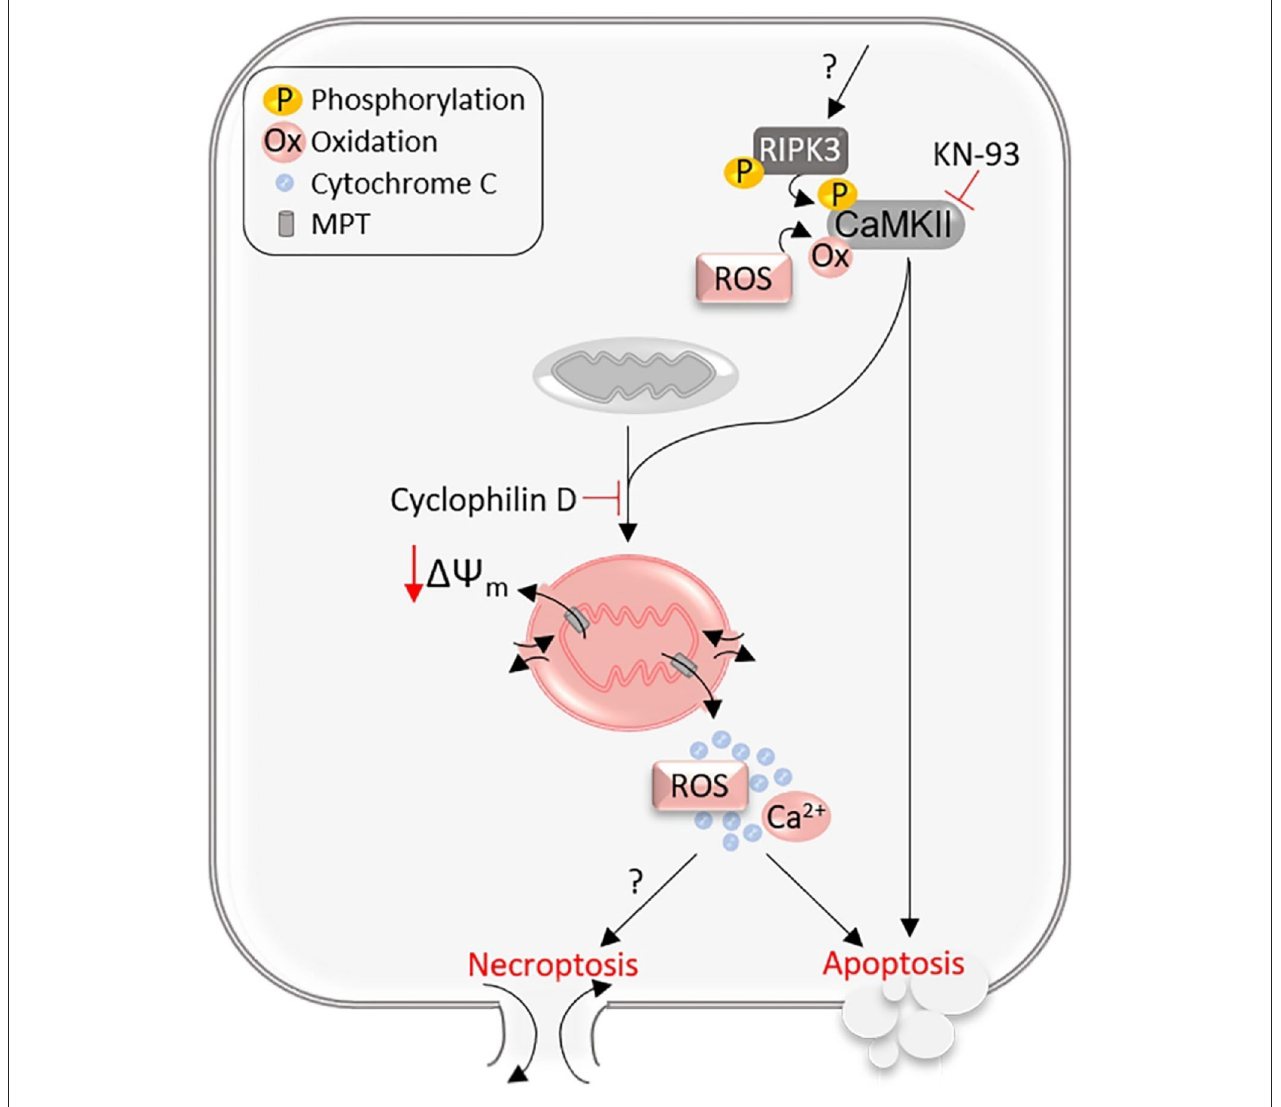
FIGURE 3 | The RIPK3–CaMKII–MPT pathway. RIPK3 phosphorylated and activated through an unknown mechanism binds to and phosphorylates CaMKII. Both phosphorylation and oxidation on CaMKII can activate CaMKII, which opens the mitochondrial membrane permeability transition (MPT) pores, inducing mitochondrial membrane depolarization ( 19 m ) and release of mitochondrial contents, and thereby the RIPK3–CaMKII–MPT pathway mediates both necroptosis and apoptosis in